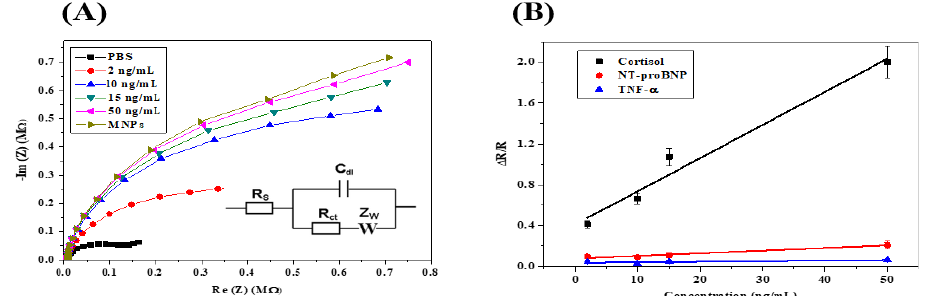
Figure 7. ( A ) Example of Nyquist plots for the Randles equivalent circuit model obtained by analyzing cortisol standard solutions in PBS (2, 10, 15, and 50 ng mL −1 ). EIS frequency ranged from 5 Hz to 100 kHz, and a sinus amplitude of 25 mV with polarization potential of − 1.5 V; ( B ) sensitivity curves obtained by analyzing standard solution containing cortisol or other HF biomarkers (e.g., TNF- α and NT-proBNP) in the concentration range 2–50 ng mL − 1 using the HfO 2 substrate functionalized with anti-cortisol antibody.